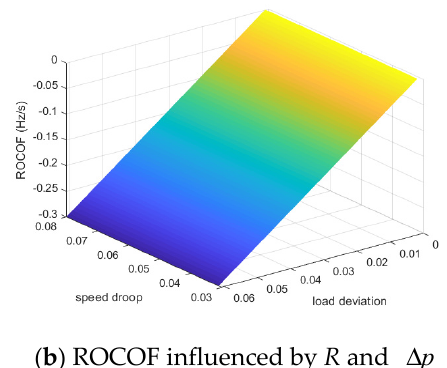
Figure 7. Composite influence on the ROCOF.